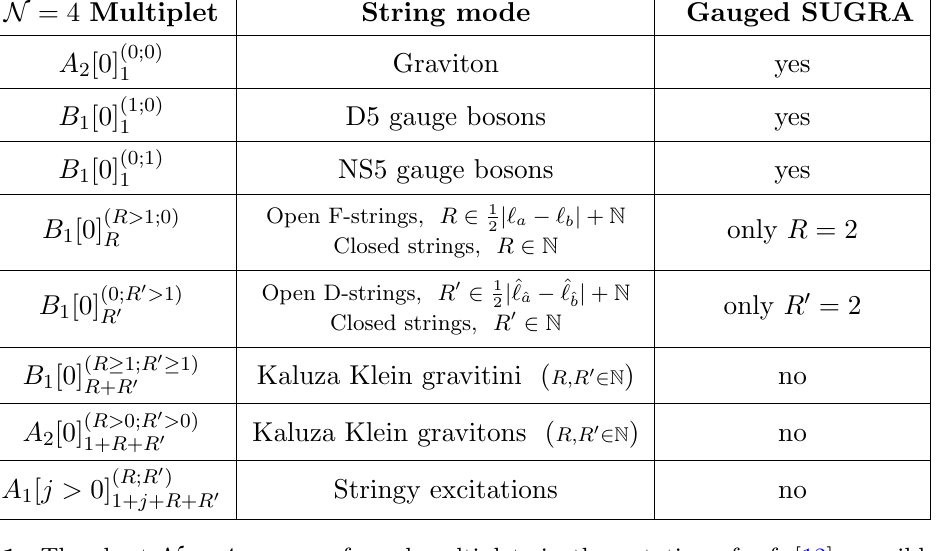
Table 1 . The short N = 4 superconformal multiplets in the notation of ref. [12], possible dual single-string excitations in the Type IIB solutions of [4, 5], and the fate of these excitations after the gauged-supergravity truncation. In the middle column N = f 1 ; 2 ; (cid:1) (cid:1) (cid:1) g is the set of non-zero natural numbers. A yes/no entry in the third column indicates that the excitation survives/does not survive in gauged supergravity. Among the R = 2 or R 0 = 2 modes some may (but need not)